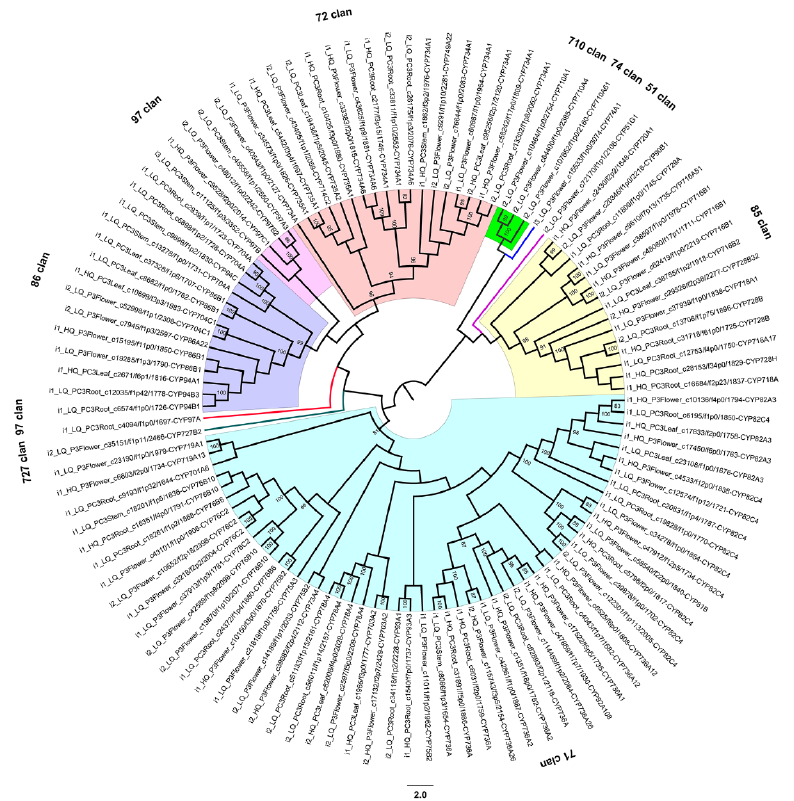
Figure 8. Phylogenetic analyses performed with 112 cytochrome P450 (CYP450) sequences of P. chienii . The classification of CYP450 protein-coding sequences was based on the reference sequences from a CYP450 database established by Nelson (https://drnelson.uthsc.edu/CytochromeP450.html) and the annotation results from the P. chienii transcriptome. Bootstrap support values over 80% are given.